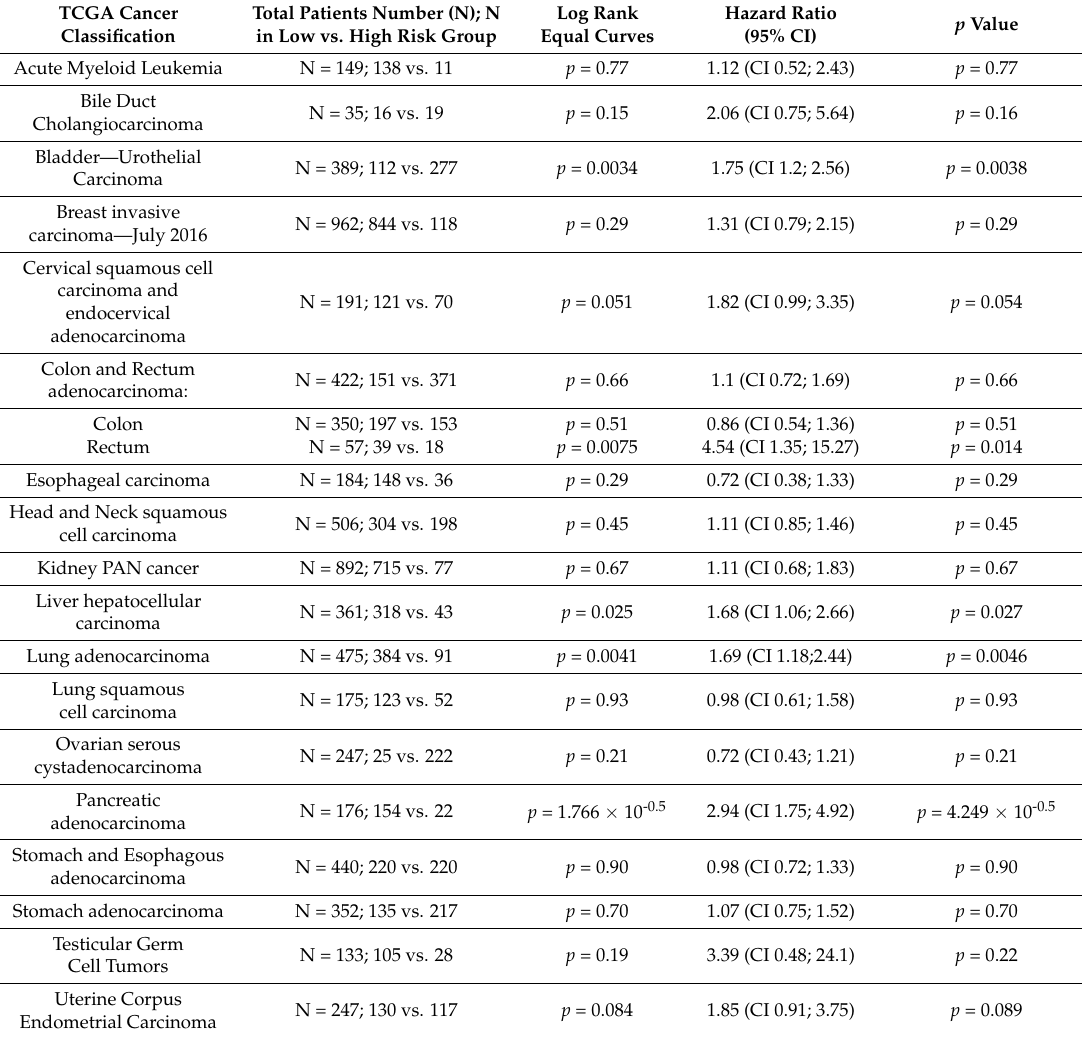
Table 2. The association of Urothelial Cancer Associated 1 (UCA1) transcript expression with cancer in The Cancer Genome Atlas (TCGA)